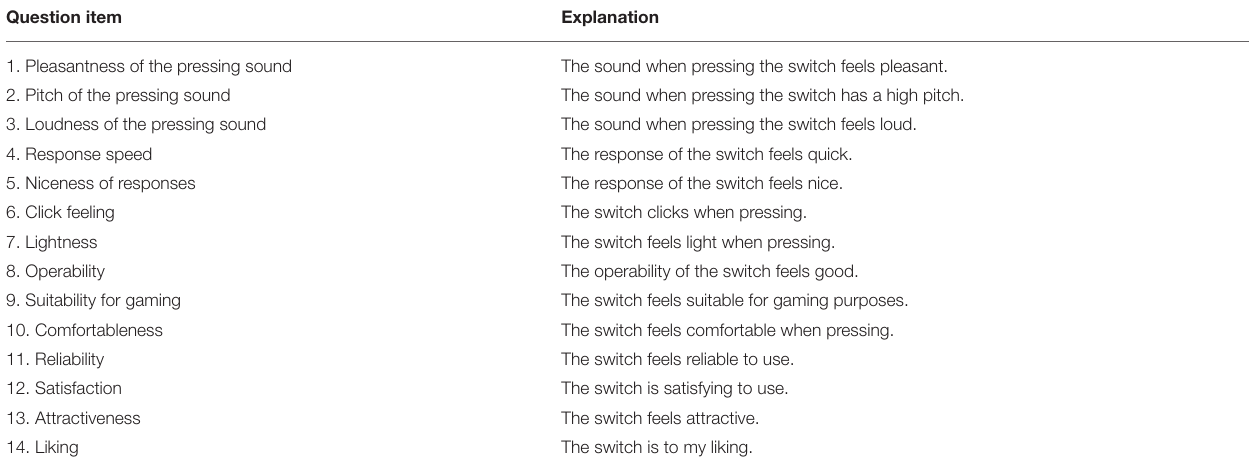
TABLE 1 | The question items in the questionnaire